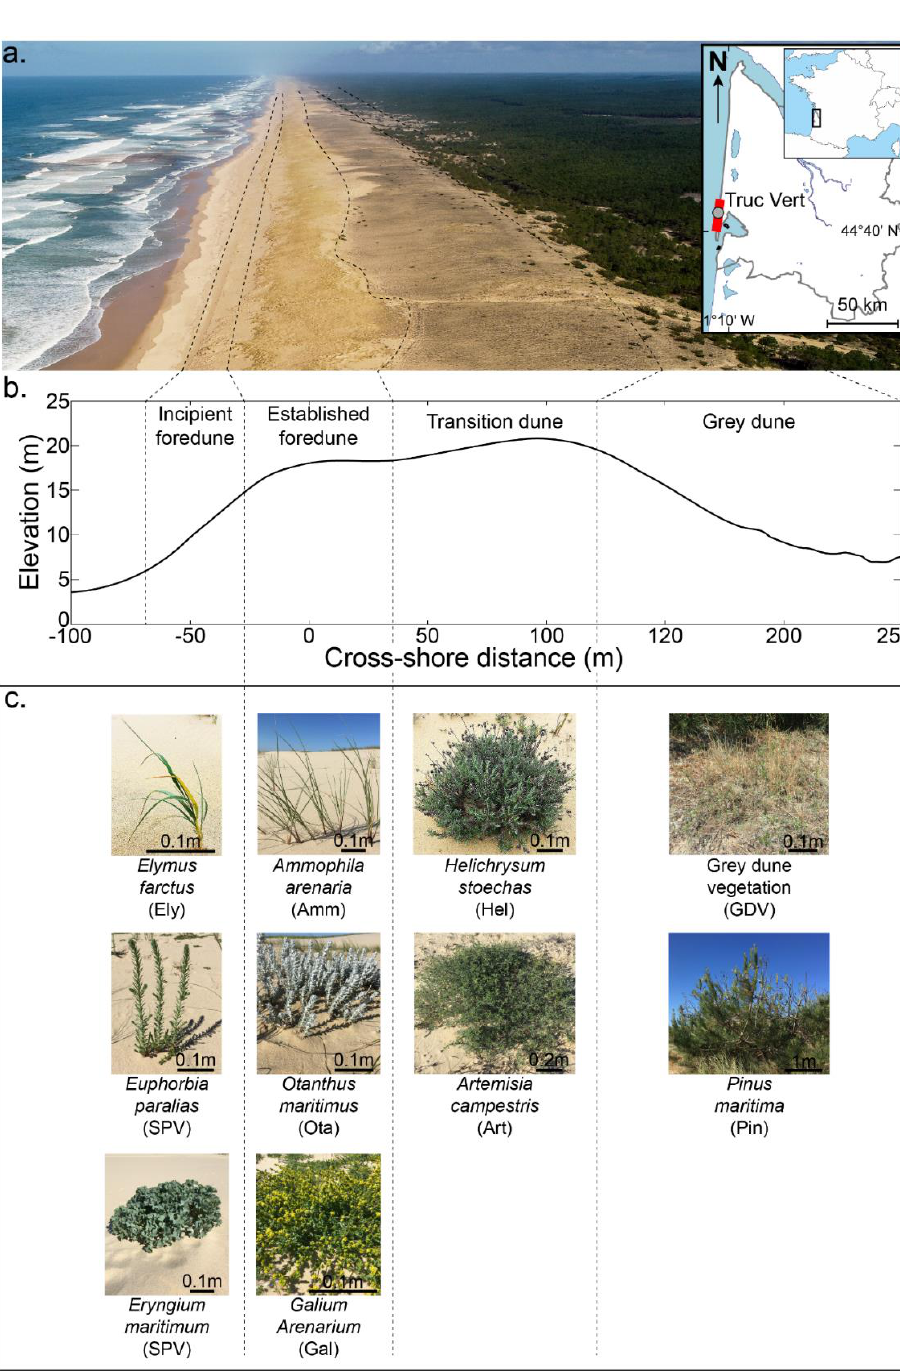
Figure 1. ( a ) Location map and aerial photograph of Truc Vert beach, representative of southwest France beaches with a well-managed alongshore-uniform coastal dune; the red line on the location map indicates the 18 km of coastline studied; ( b ) cross-shore profile of the Truc Vert beach / dune system, showing the di ff erent coastal dune units; and ( c ) photographs of the dominant coastal dune plant